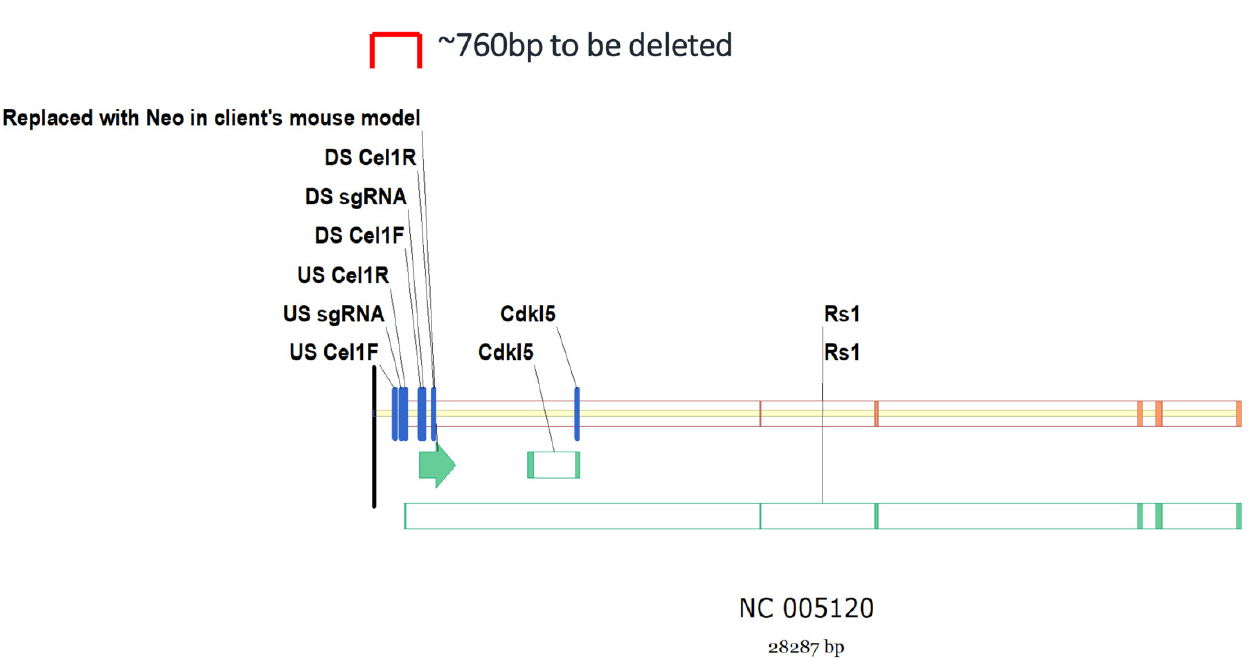
Figure 1. Generation of Rs1 -/Y rat XLRS model. Rs1-knockout (Rs1-KO) rat was generated by CRISPR/Cas9 deletion of 769 bp (genomic coordinates 794-156 p on Chromosome X_ NC 005120) that contains exon 1 of the murine Rs1 orthologue.